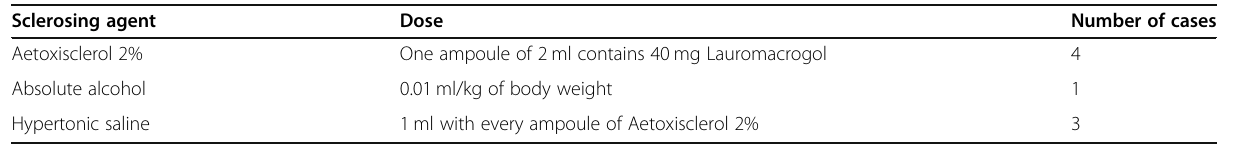
Table 3 The sclerosing agents used and their doses Sclerosing